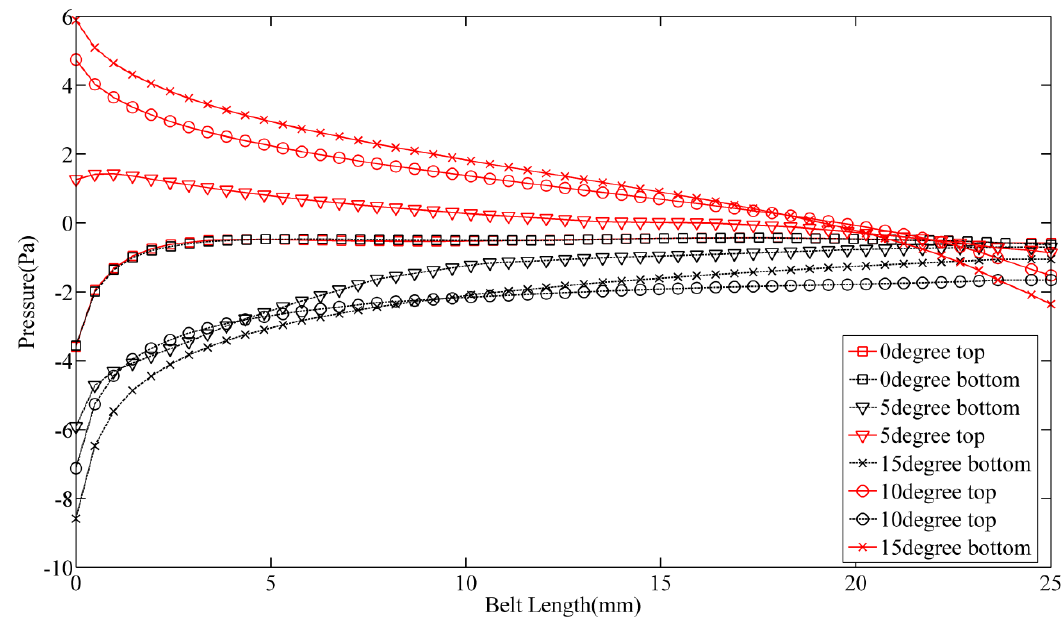
Figure 7. Pressure distribution along the belt as the attack angle was varied between 0° and